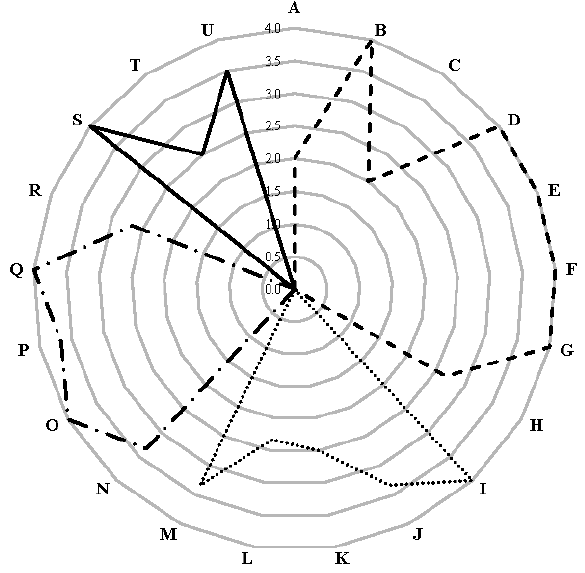
Figure 9: Radar diagram as results of the ideal level assessment for